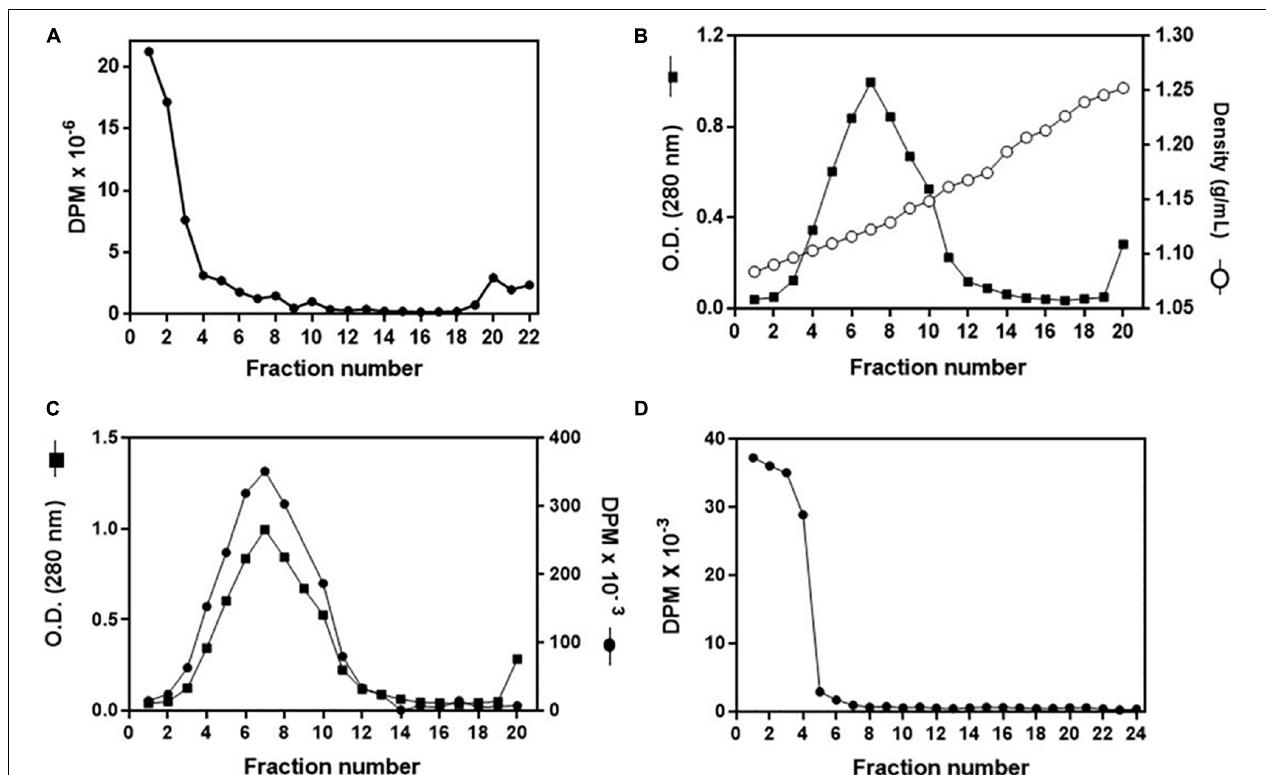
FIGURE 6 | Analysis of in vitro 3 H-cholesterol incorporation by lipophorin (Lp). (A) Non-radioactive hemolymph was incubated with 3 H-cholesterol for 16 h, and the mixture was analyzed by a KBr gradient ultracentrifugation (11–44.5% KBr). Radioactivity present in the gradient fractions was determined. (B) Fractions 1–3 from the gradient shown in (A) were pooled, and the sample was subjected to a second density gradient ultracentrifugation (0–44.5% KBr). The O.D. (280 nm) and density of each gradient fraction were determined. In (C) , values of O.D. are the same as in (B) , and the radioactivity present in each fraction was also